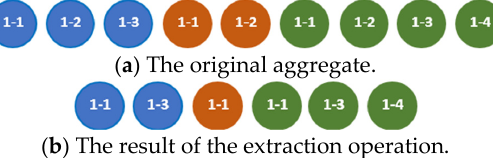
Figure 18. An example of applying the extraction operation.